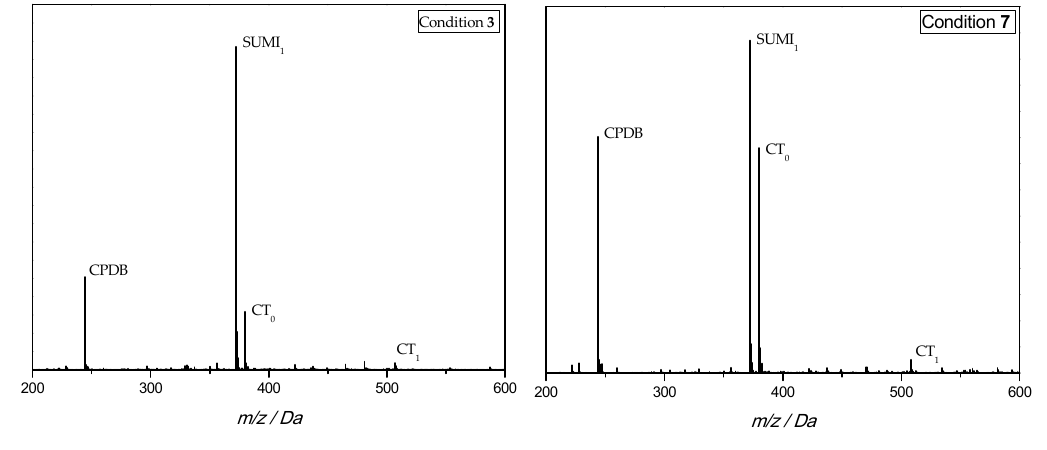
Figure 3. ESI-MS analysis for condition 3 and 7 in Table 1. Table 2. Online screening results for CPDB RAFT polymerization reactions with 5 equivalents of the monomer n -butyl acrylate and 0.25 equivalents of the thermal initiator AIBN. Condition Temp ( ◦